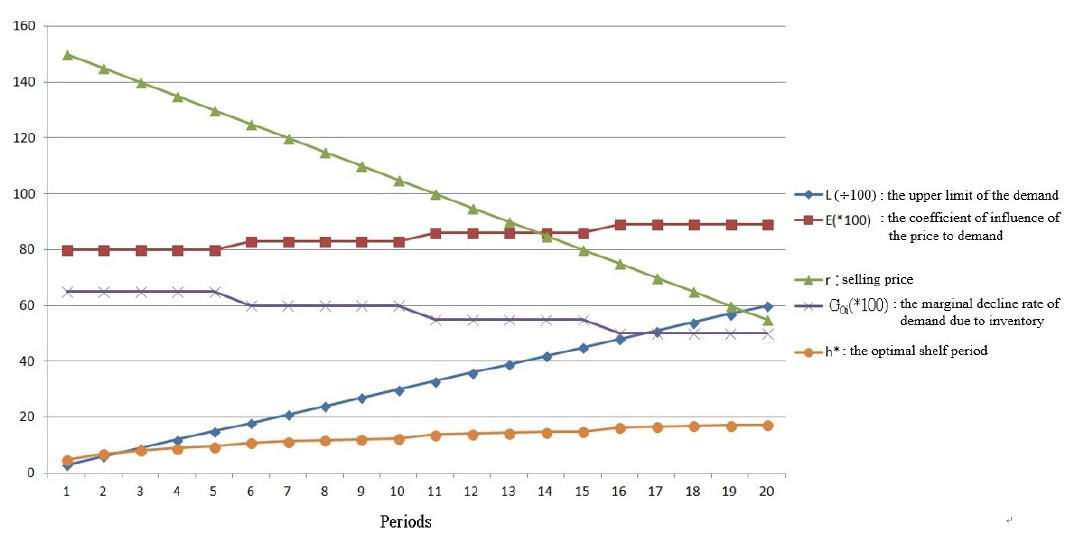
Figure 2. Influence of relevant parameters on the optimal inventory quantity.